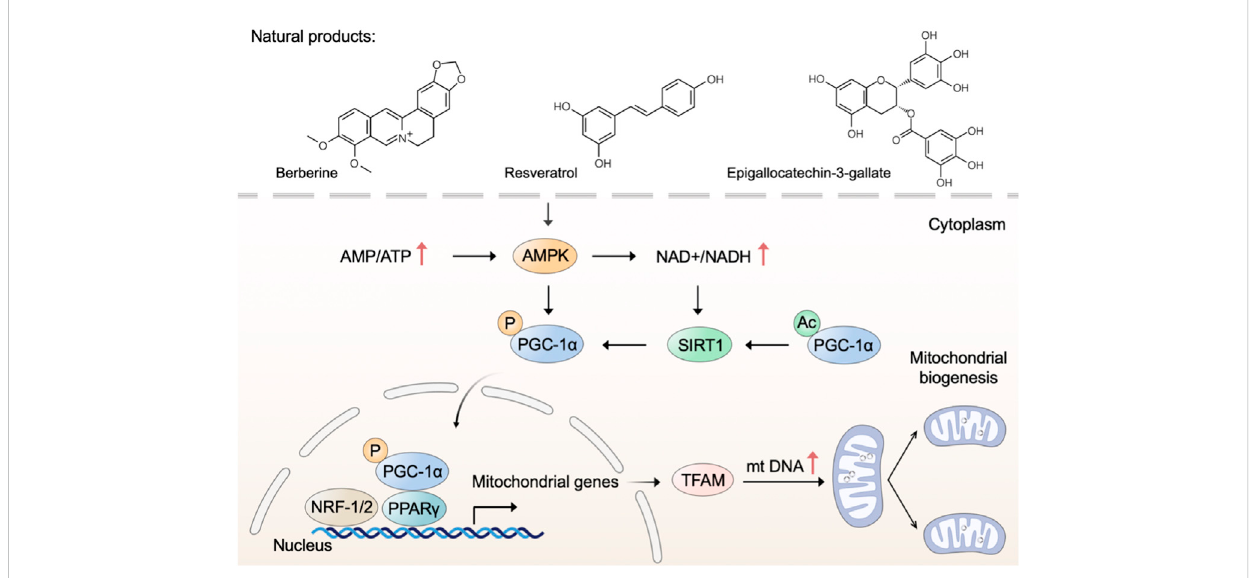
FIGURE 1 Natural products trigger mitochondrial biogenesis. Natural products such as berberine, resveratrol, and epigallocatechin-3-gallate trigger mitochondrial biogenesis through regulating the AMPK-SIRT1-PGC-1 α pathway.